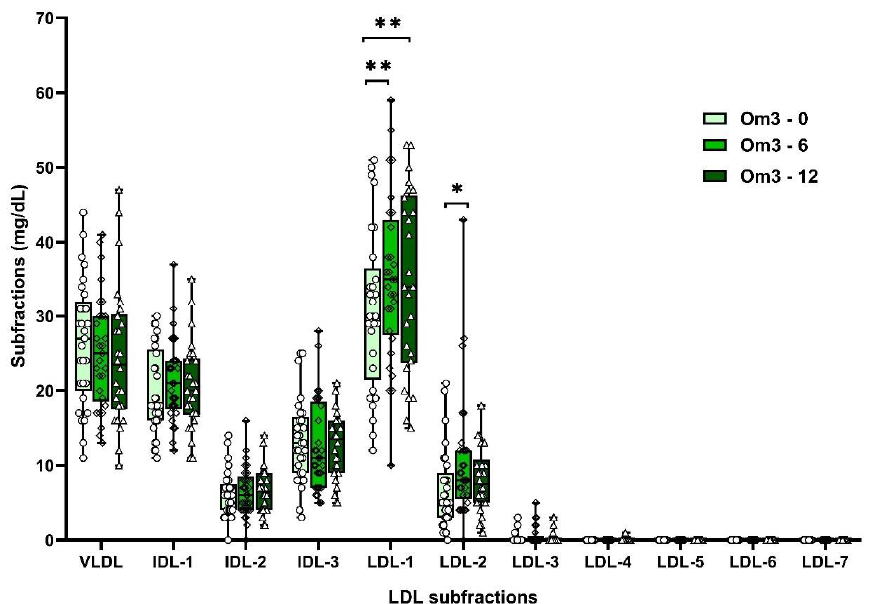
Figure 2. LDL subfractions in Om3 group at the baseline and after 6 and 12 weeks of supplementation. VLDL—very low-density lipoproteins, IDL—intermediate density lipoproteins, LDL—low-density lipoproteins, Om3—omega-3 group, * p < 0.05, ** p < 0.01.